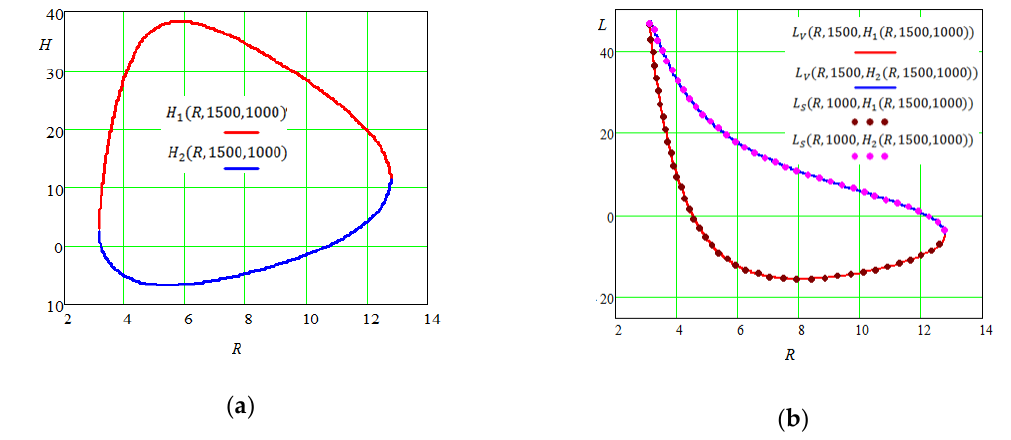
Figure 18. The correct set of the solutions of Equation (18): ( a ) solutions H ( R , V , S ) ; ( b ) values of L S ( R , S , H ) = L V ( R , V , H ) corresponding to the solutions.